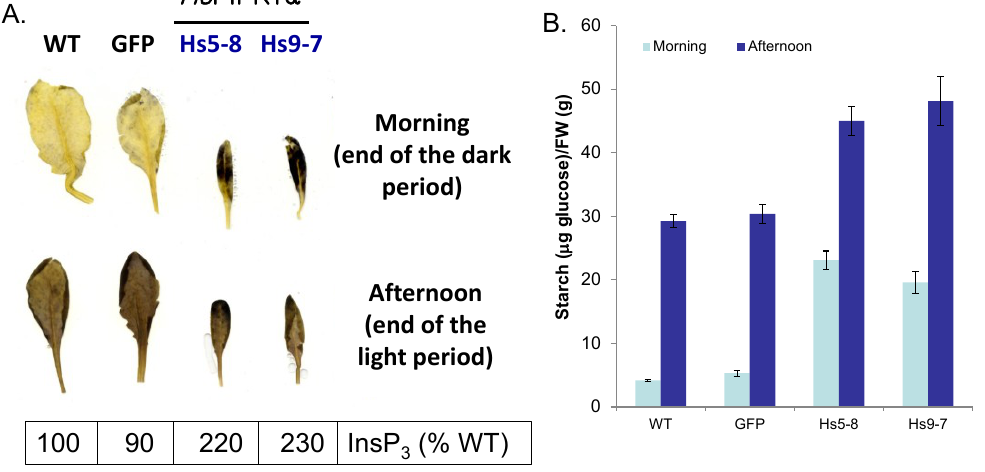
Figure 8. Biochemical and cellular analyses of starch indicated elevated levels of starch in Hs PIPKIα plants. ( A ) Leaves were harvested at the end of dark period (Morning, prior to lights coming on) or end of light period (Afternoon, prior to lights going off). Chlorophyll was removed with hot ethanol (80% [v/v]) extraction and starch was stained with 1% Iodine solution (I /KI) and photographed with a Nikon CoolPix 4500 camera. Relative 2 InsP by mass measurement is shown (WT = 100%); ( B ) Short day (8 h light/16 h dark) 3 cycle grown 3 week-old seedlings were harvested at the end of dark period (Morning) and the end of light period (Afternoon) and boiled in ethanol. Starch in the ethanol-insoluble fraction was measured after enzymatic digestion with α-amylase and amyloglucosidase to make glucose. The data are the mean of duplicate ± SD from 3 independent experiments.